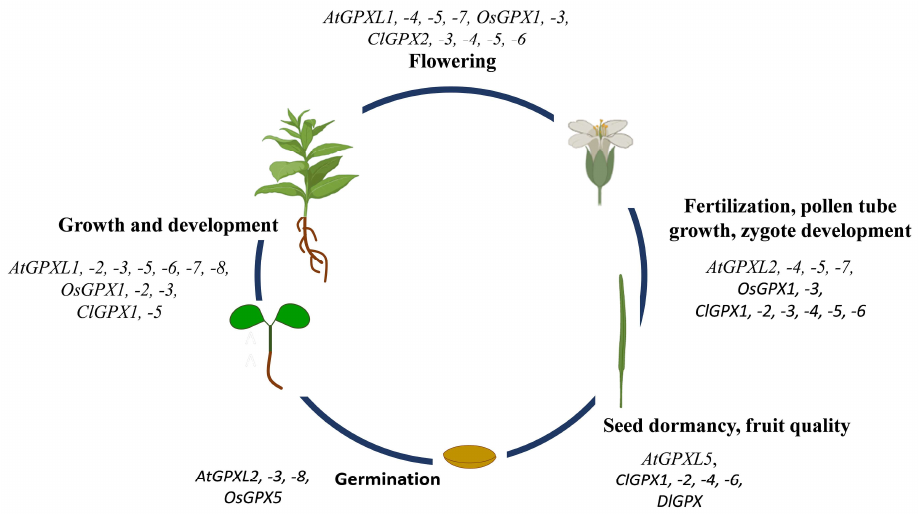
Figure 3. Schematic representation of involvement of plant GPX(L)s in growth and development in different model and crop plants based on the results published in [32,34,41,56,67,69,87,88]. At : A. thaliana , Cl : C. lanatus , Dl : Dimocarpus longan , Os : O. sativa. Some parts of the figure were created with BioRender.com (accessed on 7 August 2022).